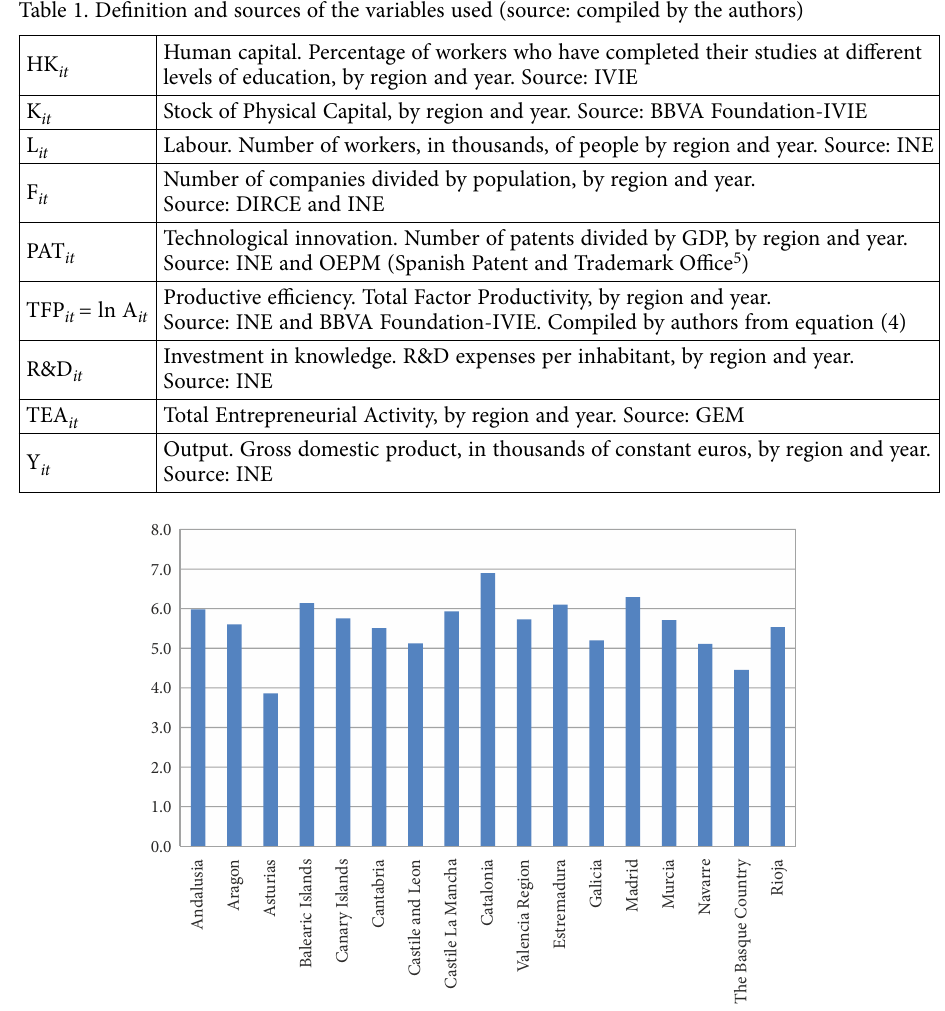
Figure 2. TEA average for the period 2003−2016 (source: compiled by the authors from the